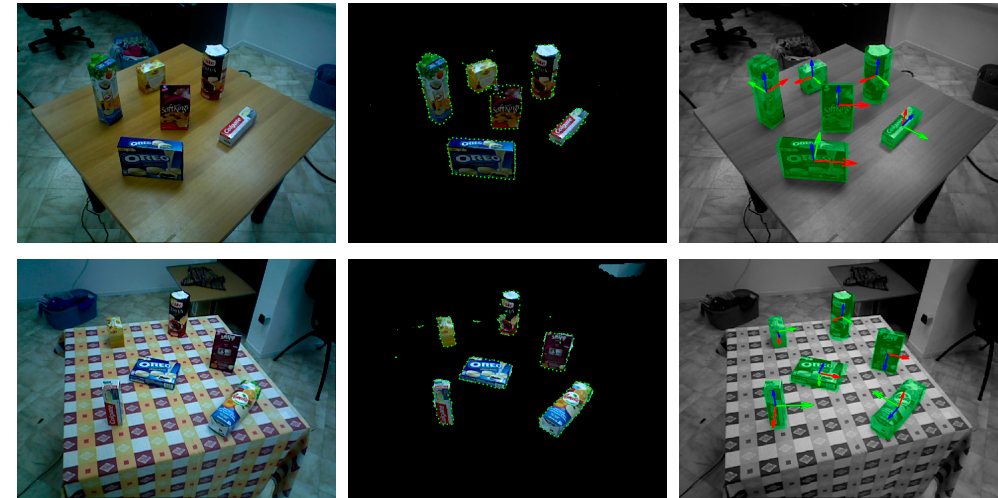
Figure 15. Some detection results on the Doumanoglou dataset. Table 5. Clutter index of each object in the Doumanoglou dataset (%).